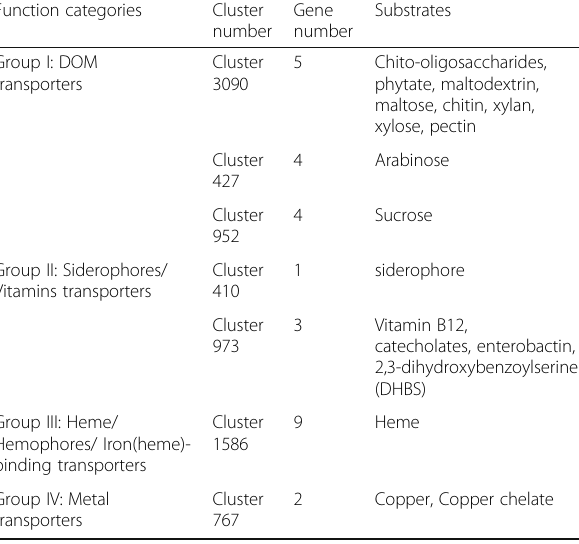
Table 7 TBDTs in the genome of A. paucihalophilus TH1 – 2